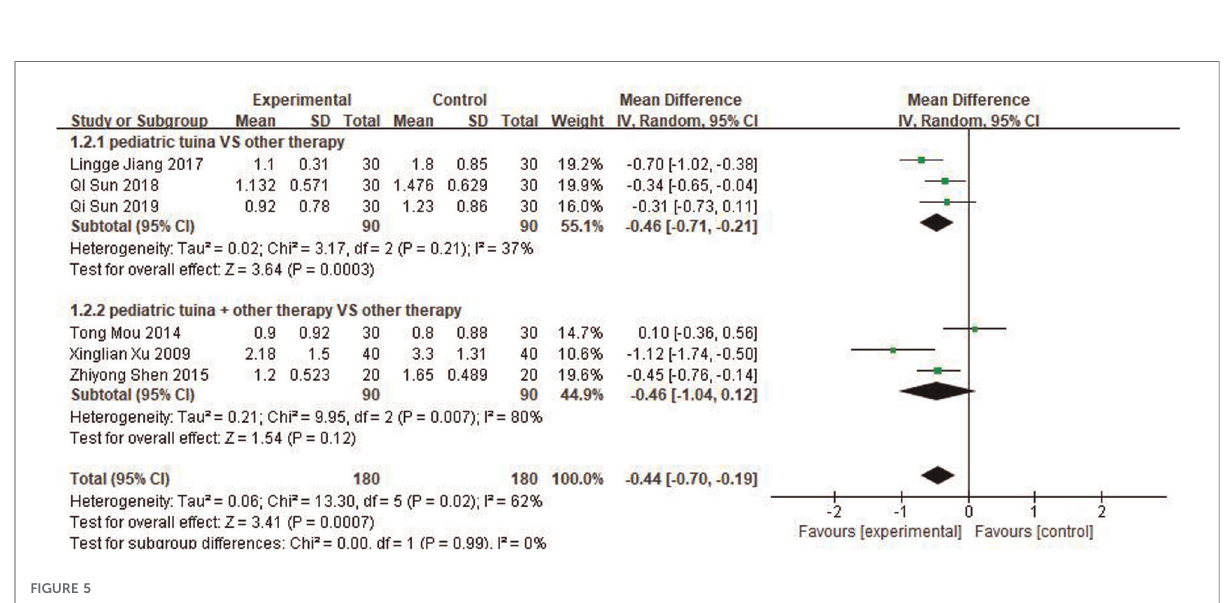
FIGURE 4 Forest plot of effective rate.